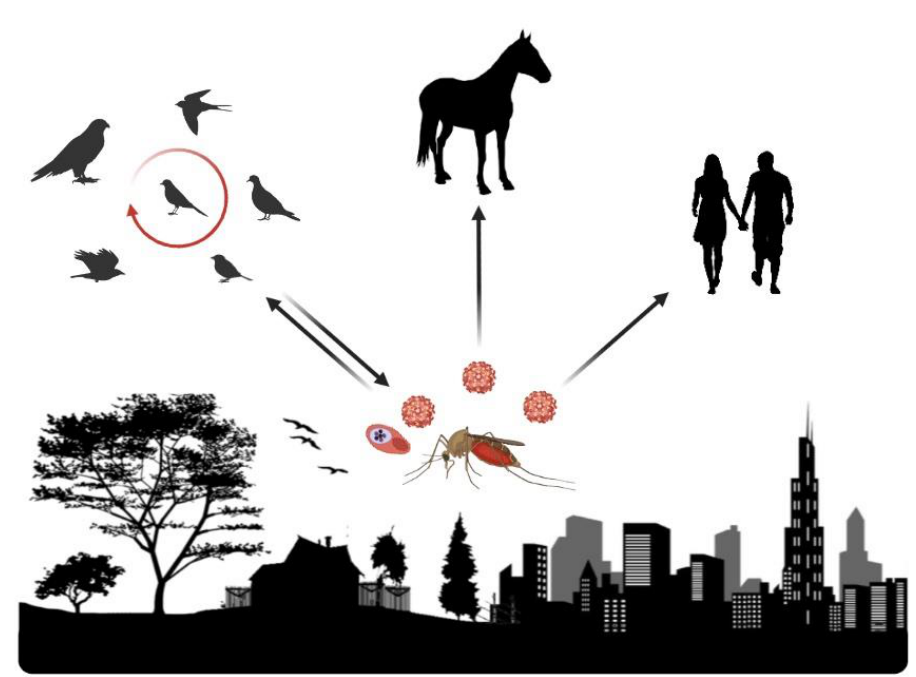
Figure 1. The life cycle of WNV and avian malaria parasites. For WNV, the primary transmission cycle takes place between mosquitoes and birds. Some infected birds develop high levels of viremia in their bloodstreams, and mosquitoes become infected after biting these infected birds. Afterwards, the infected mosquito bites other birds and transmits the virus (primary transmission cycle) or, alternatively, bites and infects people, horses, or other mammals (incidental hosts). The avian Plasmodium transmission cycle is maintained exclusively between birds and mosquitoes. Image created with © BioRender.